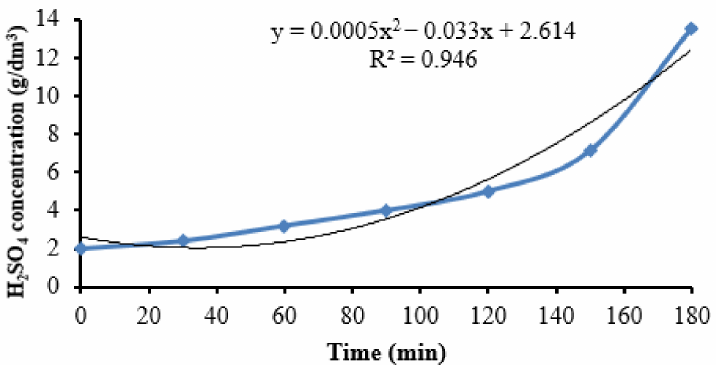
Figure 7. Change in H 2 SO 4 concentration during the electrooxidation in the flow cell. The change in voltage across the cell is shown in Figure 8. The voltage across the cell stabilizes at 6–6.5 V within 40–50 min after the start of the process, which is associated with the operation of the cell without circulation of the solution during this period of time.